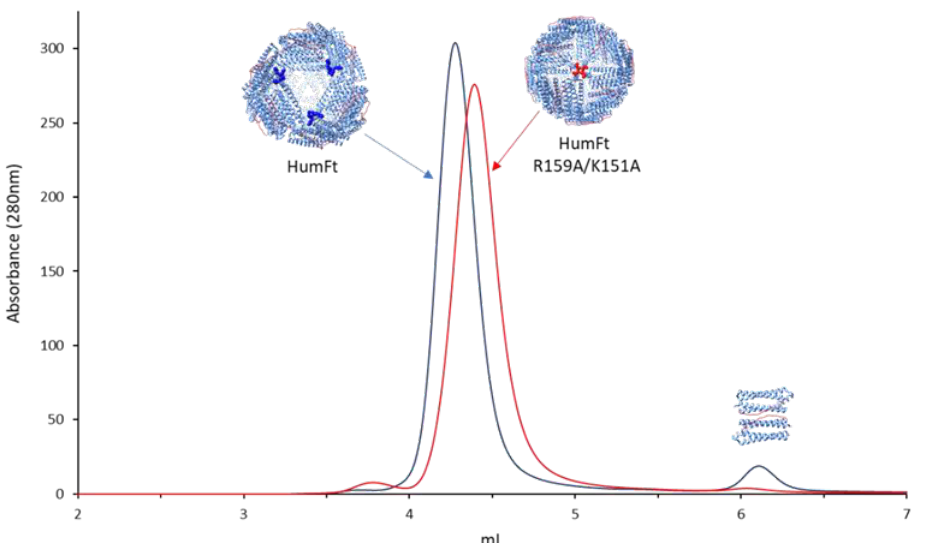
Figure 3. HP-SEC analysis of purified HumFt R150A/K151A compared to HumFt. When using 20 mM HEPES and 50 mm MgCl2 as the stationary phase, HumFt R150A/K151A is completely assembled (red chromatogram), whereas HumFt is partially dissociated as a dimer (blue chromatogram, 6.1 mL elution volume).